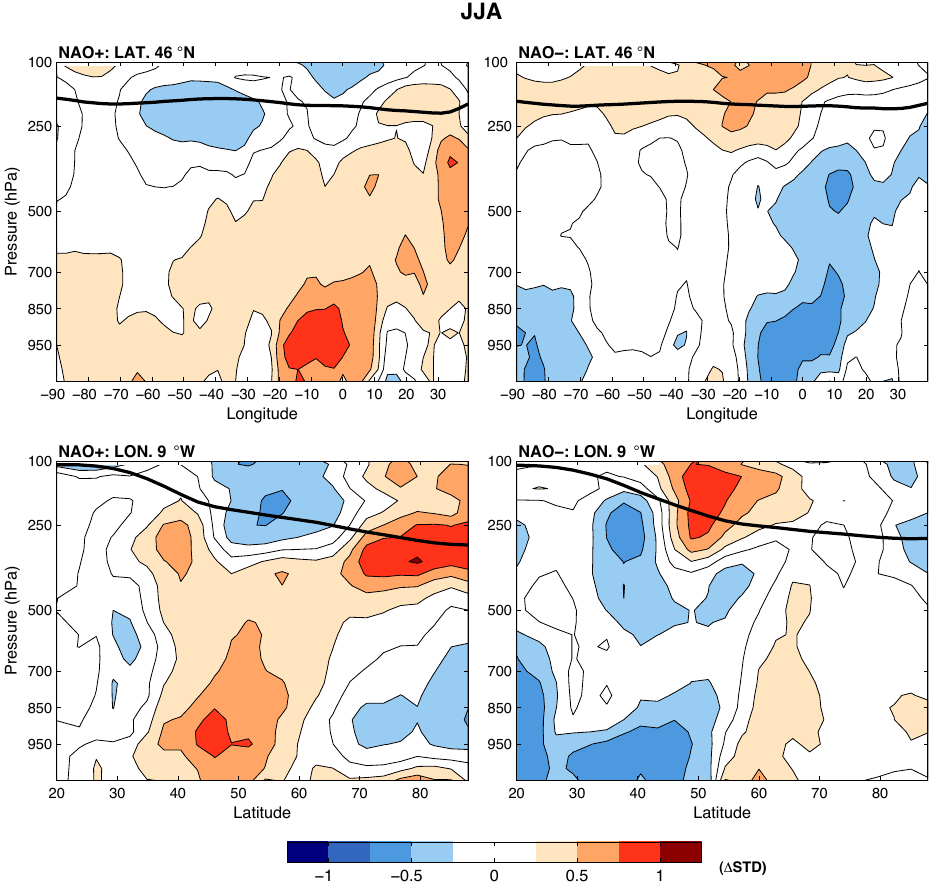
Fig. 8. Transect of normalized O 3 mixing ratio anomalies for a given latitude (upper panels) and longitude (lower panels) as a function of pressure in summer (JJA). O 3 mixing ratio anomalies are normalized by O 3 standard deviation. Thick solid line indicates the tropopause